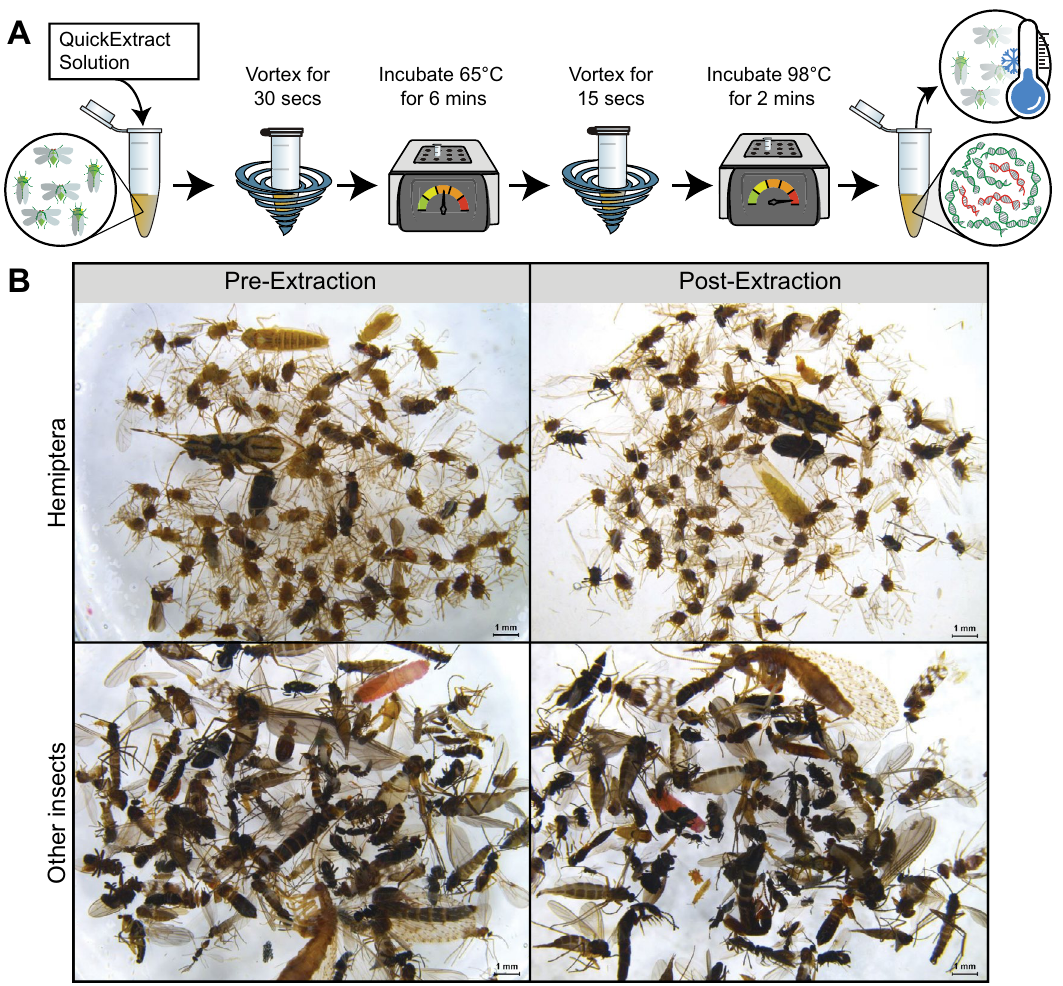
Figure 1. ( A ) Non-destructive DNA extraction protocol newly developed in this study. ( B ) Specimens from a trap sample before (left) and after (right) non-destructive DNA extraction using QuickExtract. Both Hemiptera (above) and other insect (below) specimens are